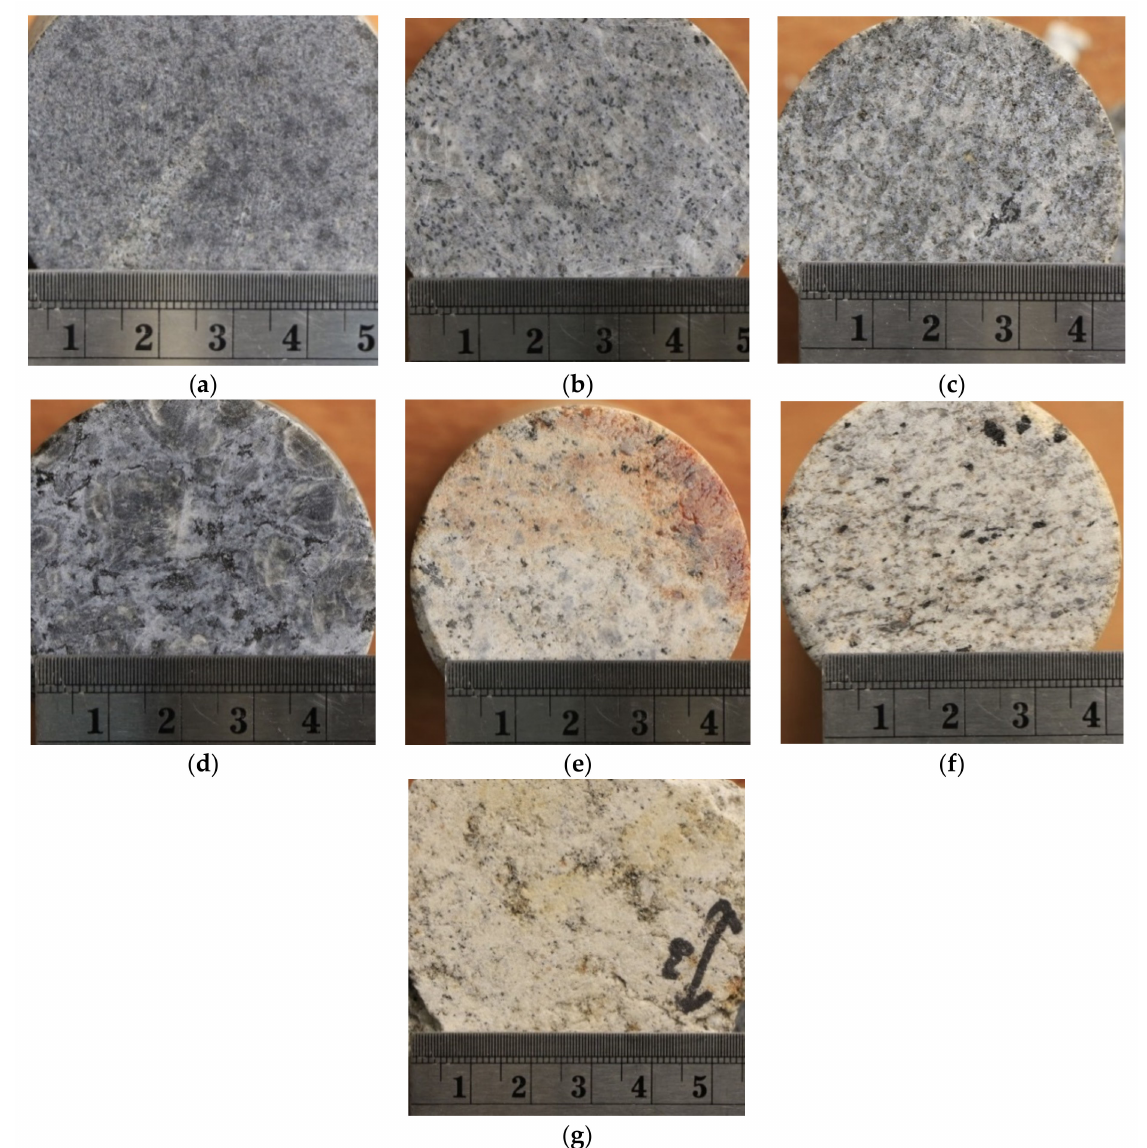
Figure 2. Photographs of the studied intrusive rocks. ( a ) Utla Dolerite (UD). ( b ) Nepheline Syenite (ANS). ( c ) Chilas Gabronorite (CGN). ( d ) Ambela Granite (AG). ( e ) Chakdara Granite-B (CGB). ( f ) Swat Granite. ( g ) Chakdara Granite-A